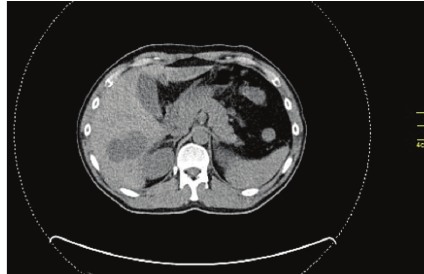
Figure 4: H&E stain, 200x.